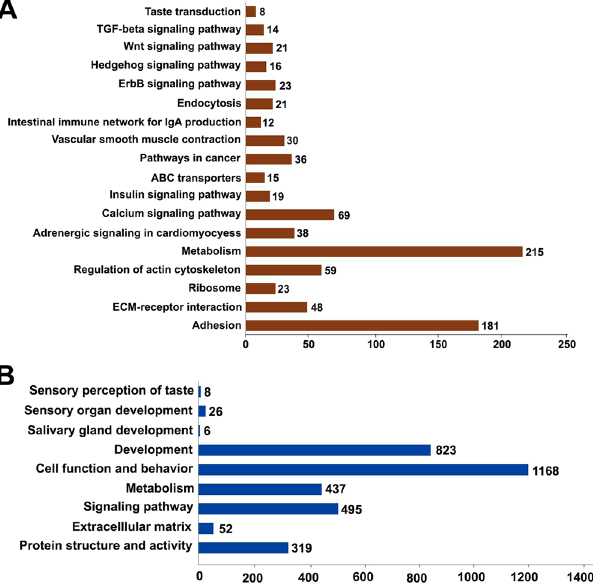
Figure 6. Histogram presentation of the number of DEGs between GE vs GM of the base of oral cavity belonging to significant pathways ( A ) and selected gene ontology (GO) terms ( B